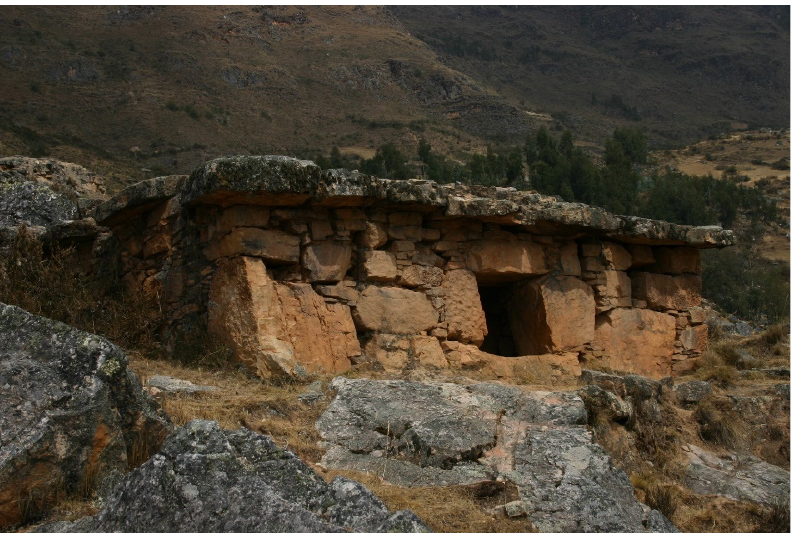
Figure 5. Typical aboveground mausoleum ( chullpa ), near Pampa Chacra, Peru; approximately 3 m wide. Large, flat roofing slabs protected a low, single-chambered interior. Small highly visible doorways allowed periodic access for small descendant collectives. Photograph by author.